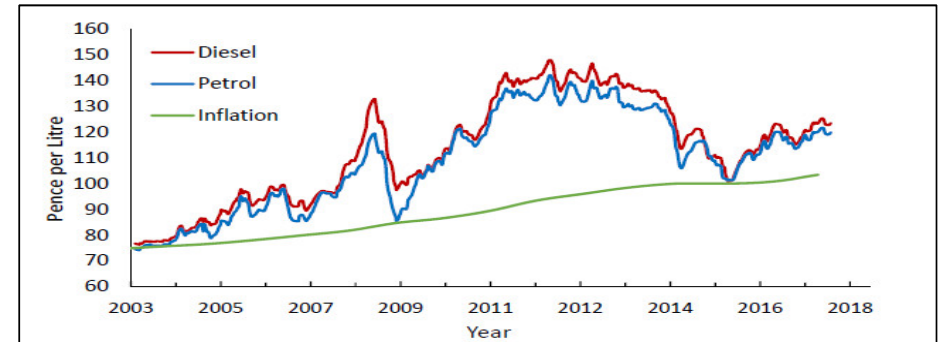
Figure 1. UK fuel prices at pump and UK inflation rates normalised to fuel prices (consumer price indexing), data from Department for Business, Energy & Industrial Strategy (2018) and Rate Inflation (2018) [2,3].